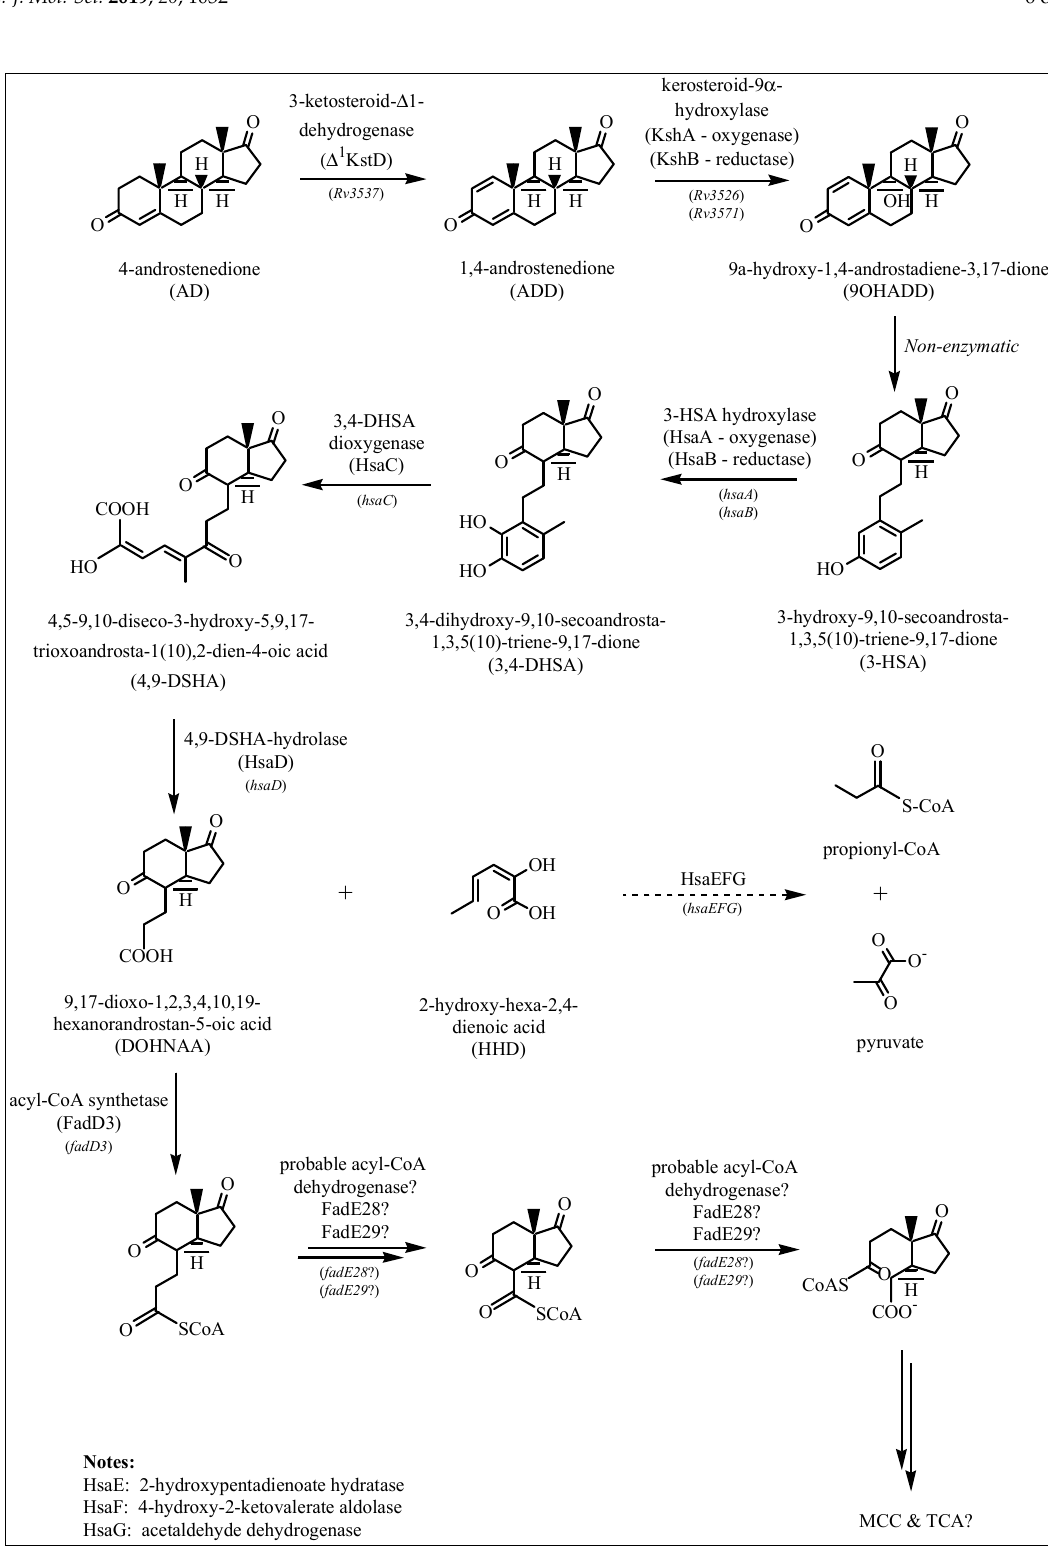
Figure 2. Cholesterol ring degradation as described in Section 2.1.2. If known, the enzymes involved in each reaction are depicted by arrows, along with the gene coding for the specific enzyme.